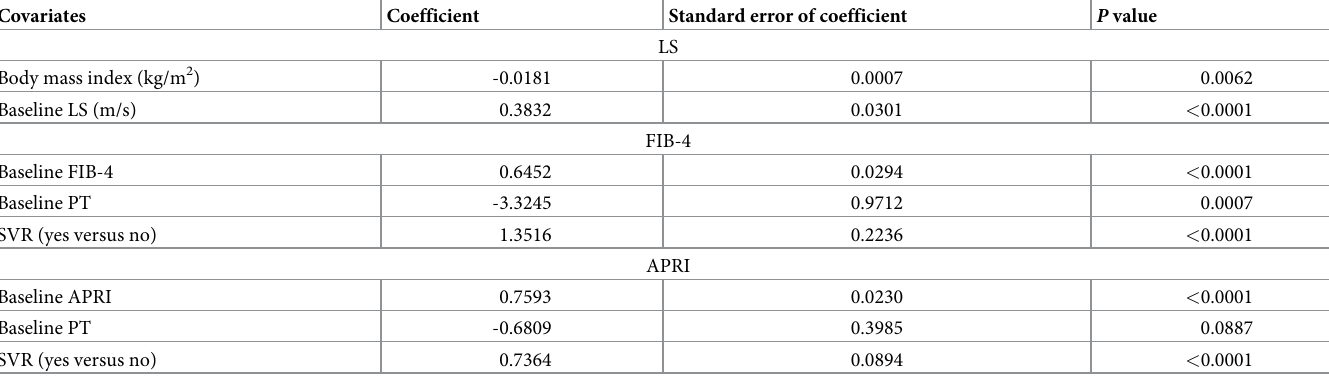
Table 4. Multiple linear regression analysis for declines in liver stiffness, FIB-4 and aspartate aminotransferase-to-platelet ratio index from baseline to sustained virologic response